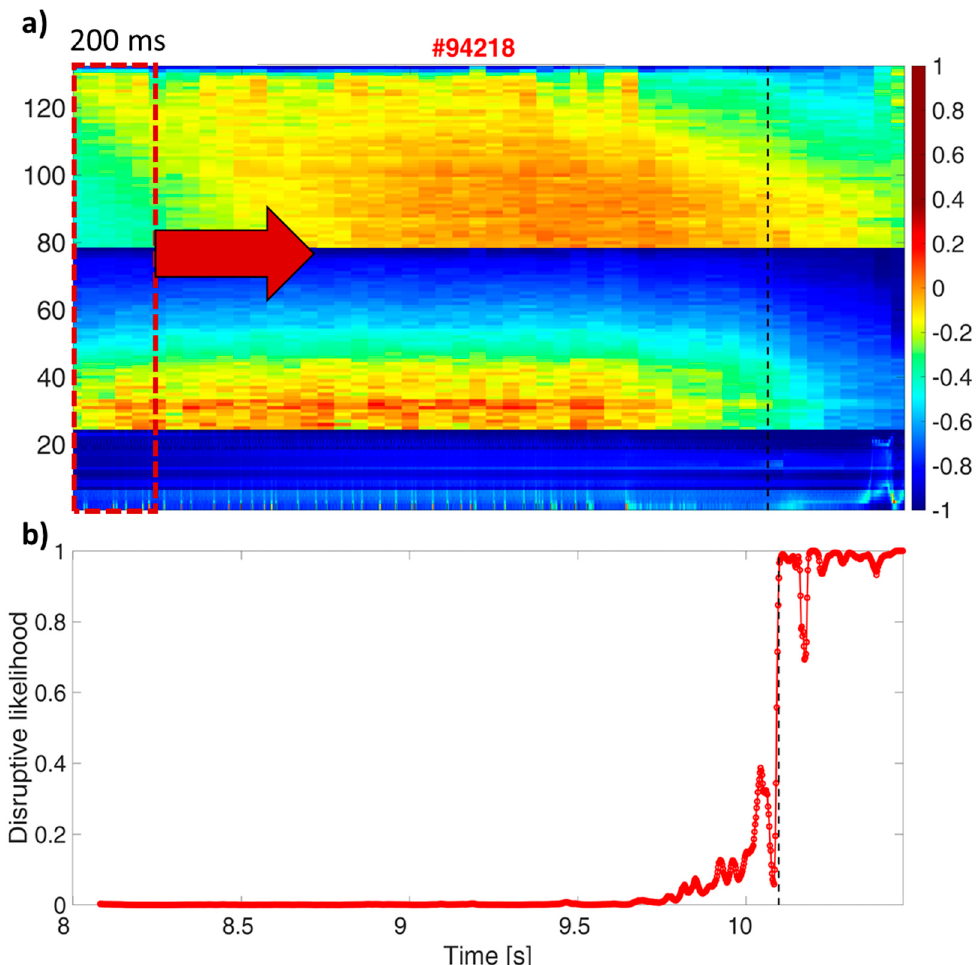
Figure 8. ( a ) CNN input image of the disrupted discharge #94218; ( b ) disruptive likelihood of the disrupted discharge #94218. The dashed black line identifies the alarm time.